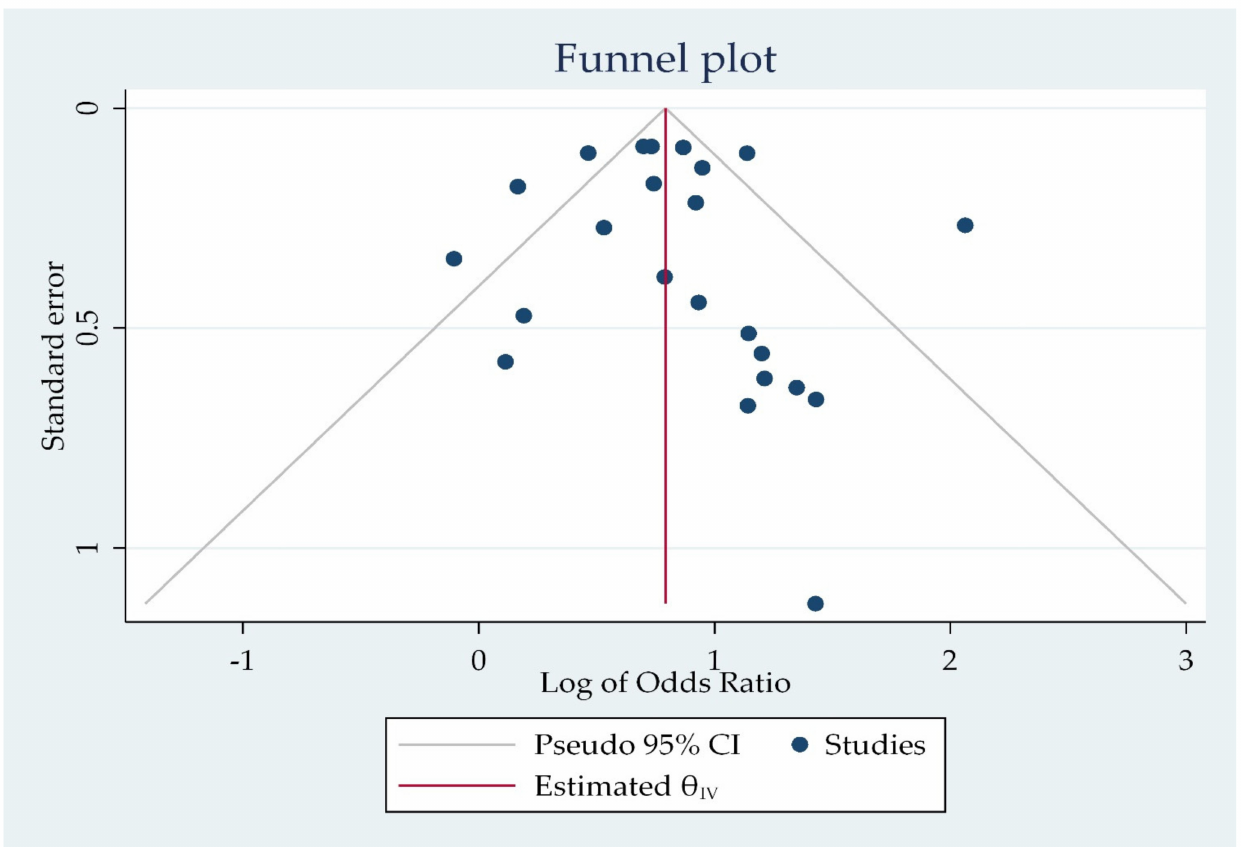
Figure 4. Funnel plot for odd’s ratio values and their